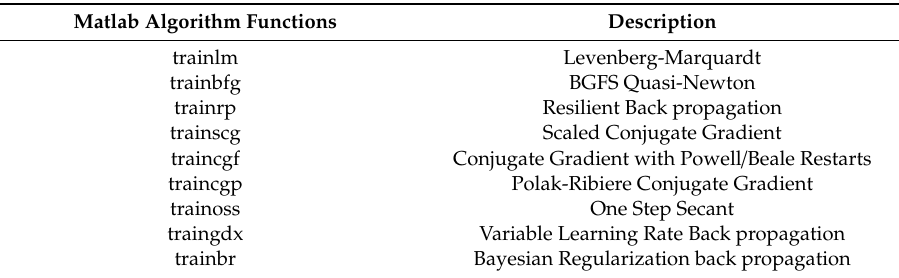
Figure 3. The layered structure of the artificial neural network (ANN). Table 2. Training algorithms of a ANN in Matlab and their description .